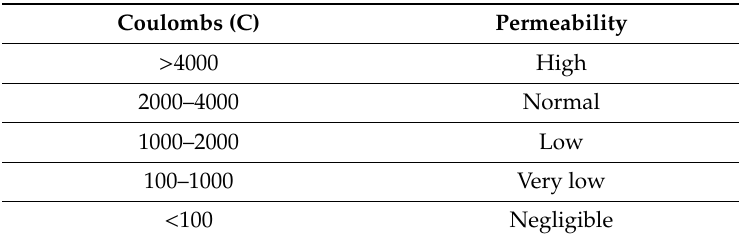
Table 8. Evaluation according to chloride ion permeability.